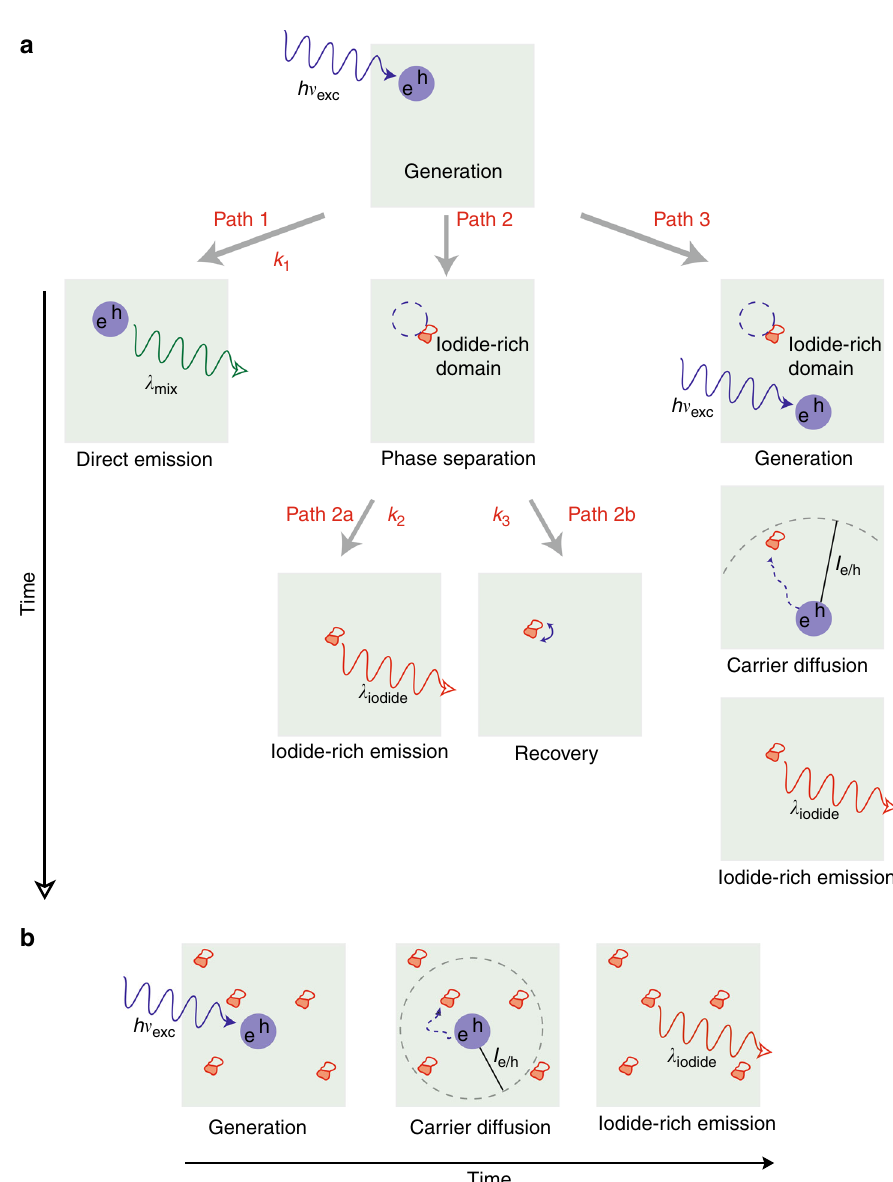
Fig. 2 Schematic of relevant kinetic processes during halide phase segregation. a low and b high excitation intensity light-induced phase separation of MAPb(I 1 − x Br x ) 3 (MA = CH 3 NH 3 + ). Microscopic rate constants ( k 1 − 3 ) associated with the underlying kinetic model have been provided. Dark circles denote photogenerated electron – hole pairs. Empty circles denote electron – hole pairs which have induced phase separation. Filled red and white regions represent phase separated iodide-rich and corresponding bromide-rich mixed MAPb(I 1 − x Br x ) 3 from MAPbI 3 and MAPbBr 3 is small and slightly positive (on the order of 0.01 eV FU − 1 ) up to x = 1/3 and